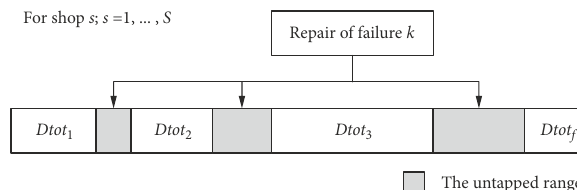
Figure 2. Illustration of repairs’ scheduling in untapped ranges